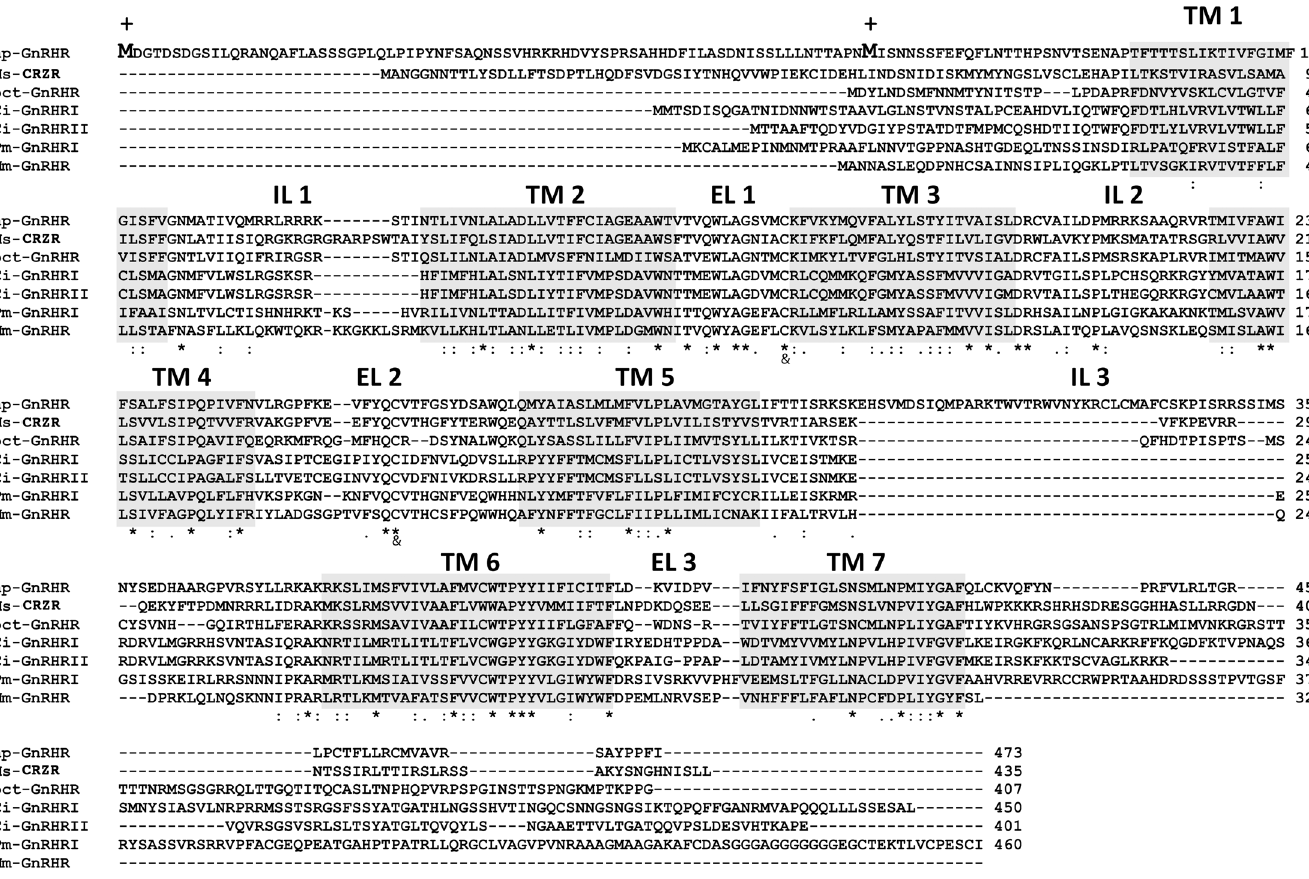
( Lottia gigante a) and an oyster ( Crossostrea gigas ). These molluscan receptors cluster with